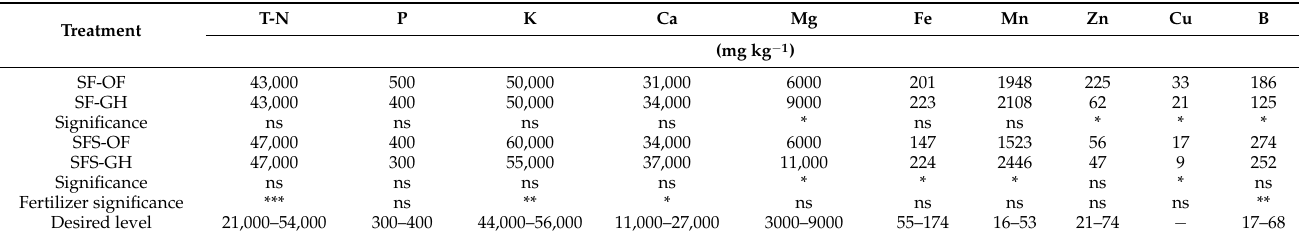
Table 5. Plant mineral nutrients as affected by starfish (SF)- and starfish + seaweed (SFS)-liquid fertilizers applied in open-field (OF) and greenhouse (GH) cultivated red peppers.